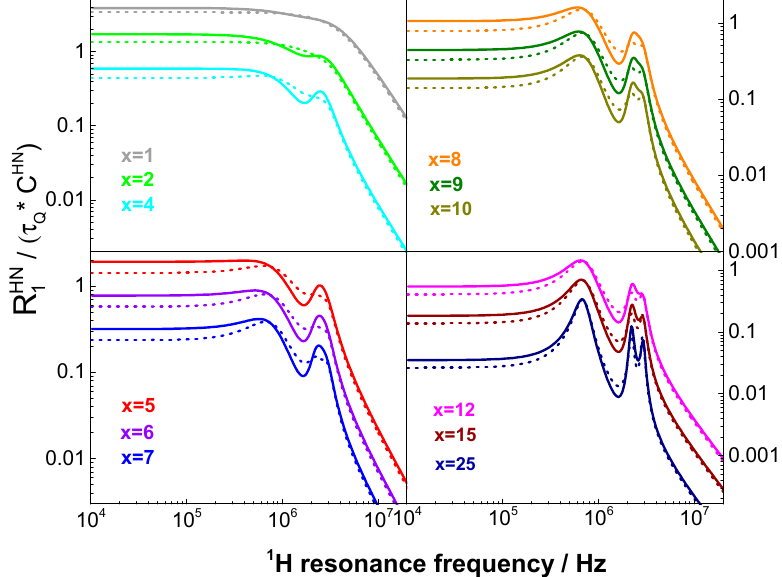
Figure 1. Simulated 1 H– 14 N spin–lattice relaxation contribution: comparison between the predictions of the SLE approach (solid lines) and of Equation (4) (dashed lines) depending on the value of the product: x = ω Q τ Q . For clarity of the figure, the simulation results have been divided by a factor of 2 for x = 2,6,9,15 and by a factor of 4 for x = 4,7,10,25. C HN = 2 are 4.68 × 10 − 8 s − 1 ( x = 1); 9.36 × 10 − 8 s − 1 ( x = 2), 1.17 × 10 − 6 s − 1 ( x =